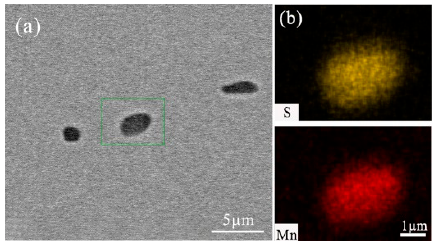
Figure 2. Pure MnS inclusions in test steel ( a ) SEM morphology of inclusions; ( b ) composition distribution of inclusions.